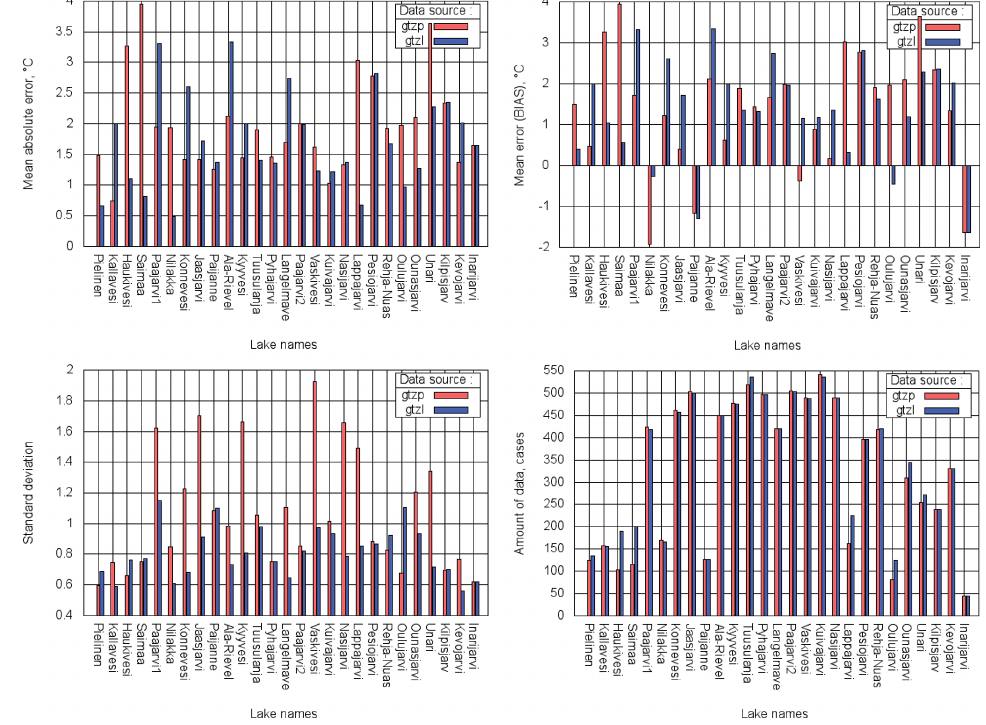
Figure 16. Same as Fig. 14 but calculated over all autumn mixing periods.